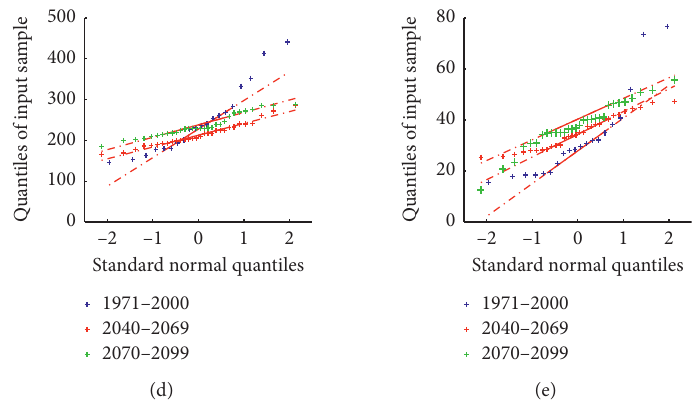
Figure 13: Quantile-quantile plots of historical and projected precipitation under RCP8.5 scenario: (a) year, (b) spring, (c) summer, (d) autumn, and (e) winter,